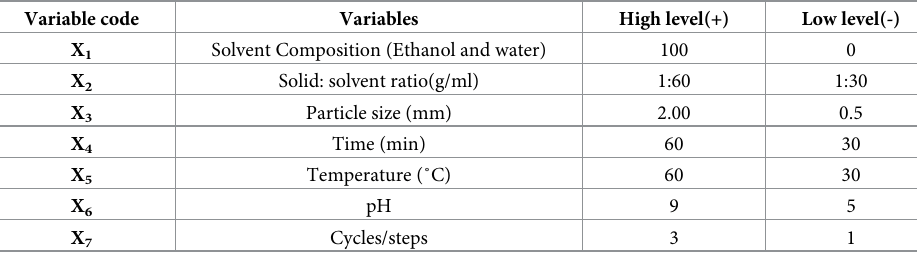
Table 2. Different extraction parameters used for diosgenin extraction from D . deltoidei